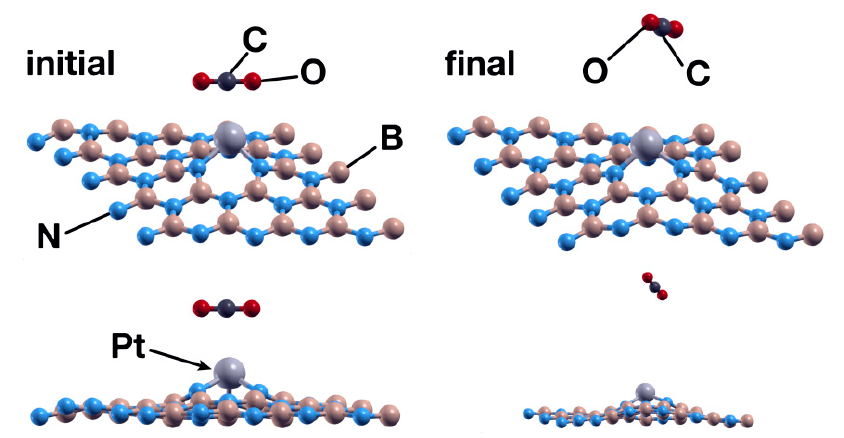
Figure 10. Initial ( left ) and final ( right ) configurations for the interaction of the hBN surface with a Pt absorbed in a B vacancy and a CO 2 molecule. In this case, the system repels the CO 2 molecule.